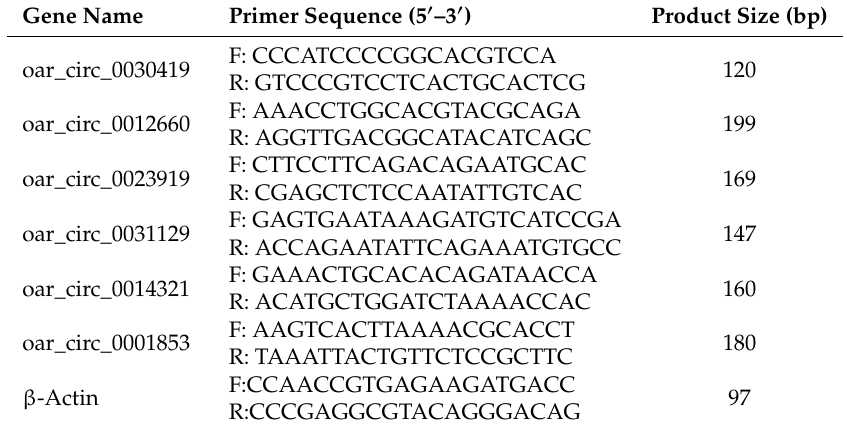
Table 1. Details of primer sequences used for qRT-PCR and expected product sizes of